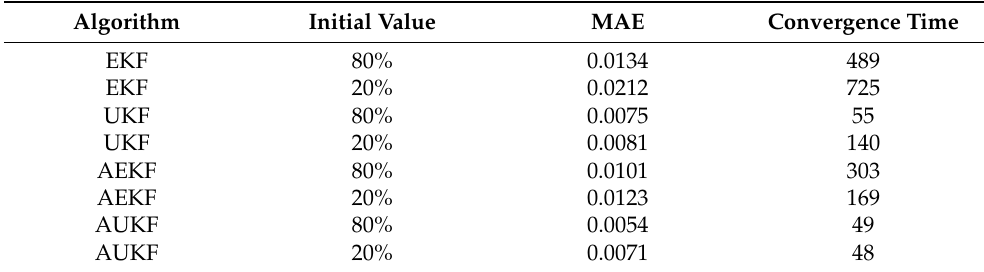
Figure 15. Estimation results at an initial SOC of 20% via the FUDS. ( a ) SOC estimation comparison curve; ( b ) SOC estimation error. Table 6. Comparison results of the four calculation methods via the FUDS.